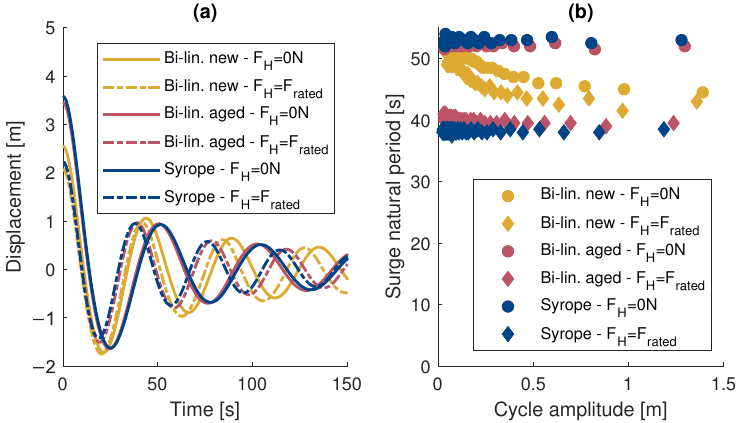
Figure 10. Force–displacement relationship for the full mooring system, with dynamic relationships given for loading about mean horizontal external forces of 0.6 and 1.2 MN. The swivel displacement is given relative to the position of the swivel when there are no external loads on the system.